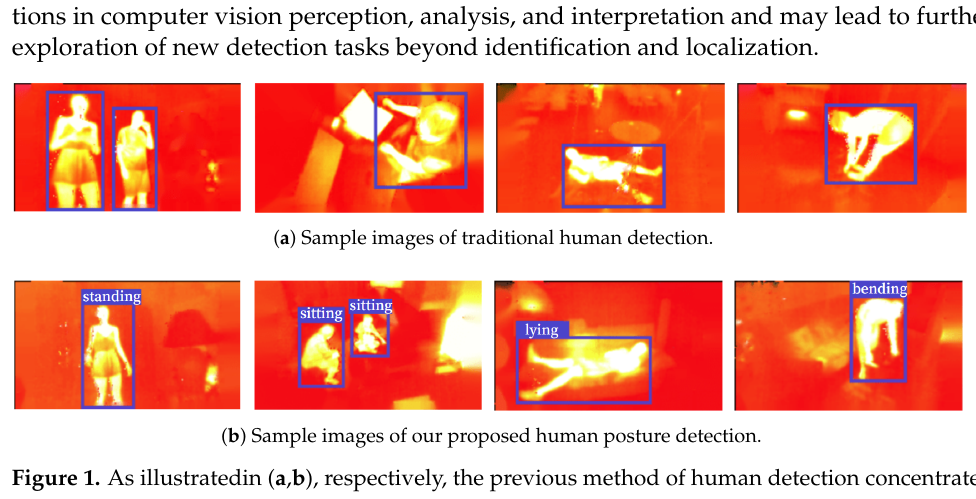
Figure 1. As illustratedin ( a , b ), respectively, the previous method of human detection concentrated on the identification and localization of humans; however, we also pay attention to additional information, i.e., the human posture. Note ( b ) marks the postures of the human (i.e., ‘standing’, ‘sitting’, ‘lying’, and ‘bending’ from left to right, respectively.)